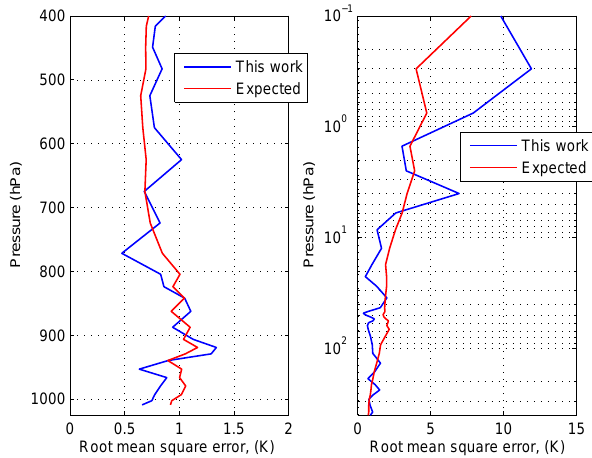
Fig. 11. The root mean square difference between retrieved and dropsonde/ECMWF temperature profiles (blue line). The figure also shows (red line) the root mean square error based on simula- tions. Panel (a) shows the altitude range where we have dropsonde observations, while panel (b) shows the altitude range where the temperature information is derived from the ECMWF short-term forecast fields.